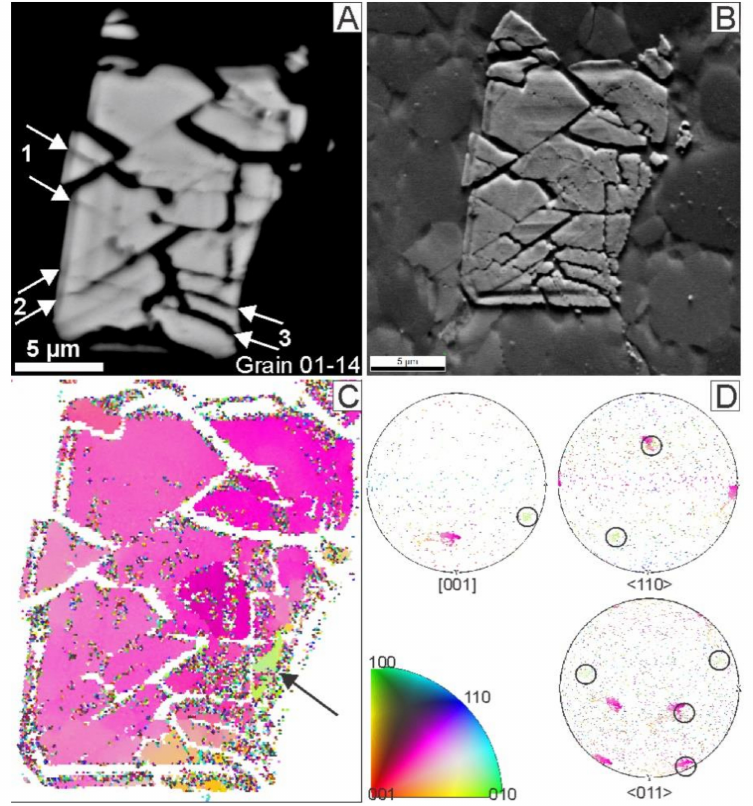
Figure 11. Microstructural details of the zircon grain 01-14, located ~7.5 mm from the PT vein. The grain contains planar fractures (PFs), highlighted as 1-3. ( A ) BSE image, three sets of PFs are visible (arrows). ( B ) Orientation contrast (FSE) image. ( C ) EBSD map, color-coded in the IPF colors along the [001] axis. Step size 90 nm. Arrow points to the (sub)grain with a di ff erent orientation, highlighted with the circles in ( D ). ( D ) Upper hemisphere equal angle projection pole figures for [001], < 110 > and < 011 > , color-coded as in ( C ). Circles highlight the orientation of the green domain in ( C ). Plotted with the MATLAB MTEX